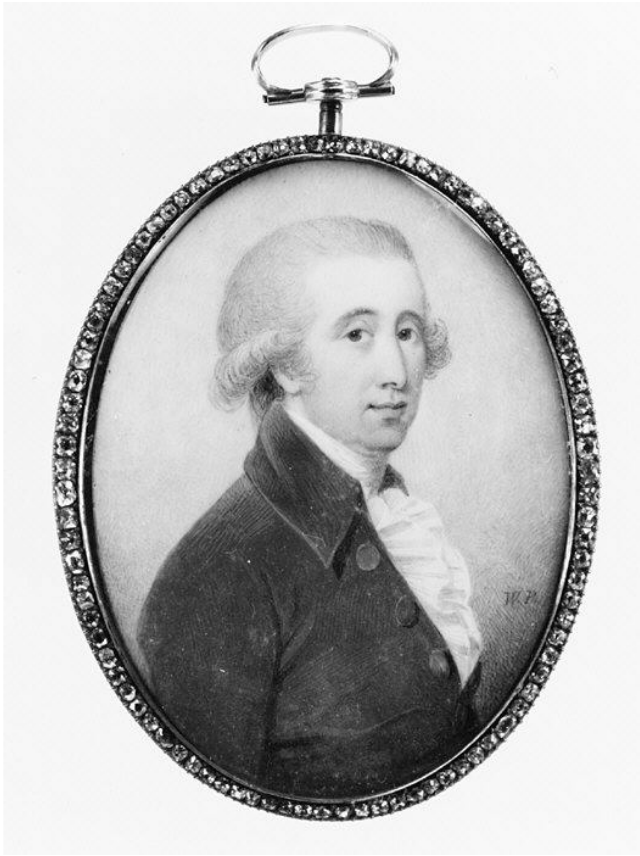
Figure 3. William Pether, Portrait of a Man (A Man with the Initials FM) , latter half of the 18th century, watercolor on ivory, 75 × 56 mm. The Metropolitan Museum of Art, New York. Credit line: The Metropolitan Museum of Art, New York; Open Access policy.